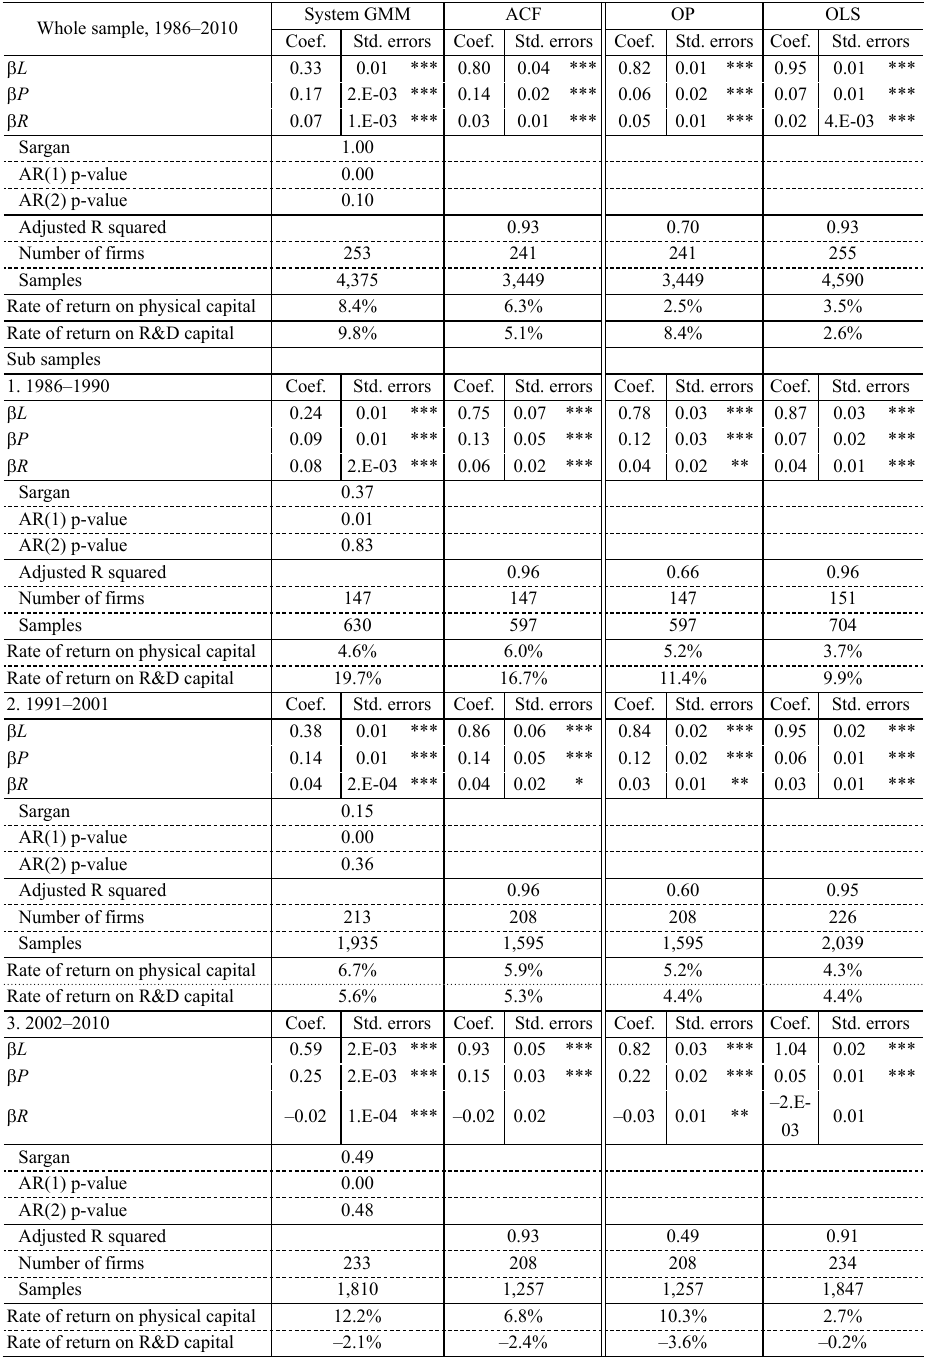
Table 5. Comparison of results from the four estimation methods for electric and electronic firms System GMM Whole sample, 1986–2010